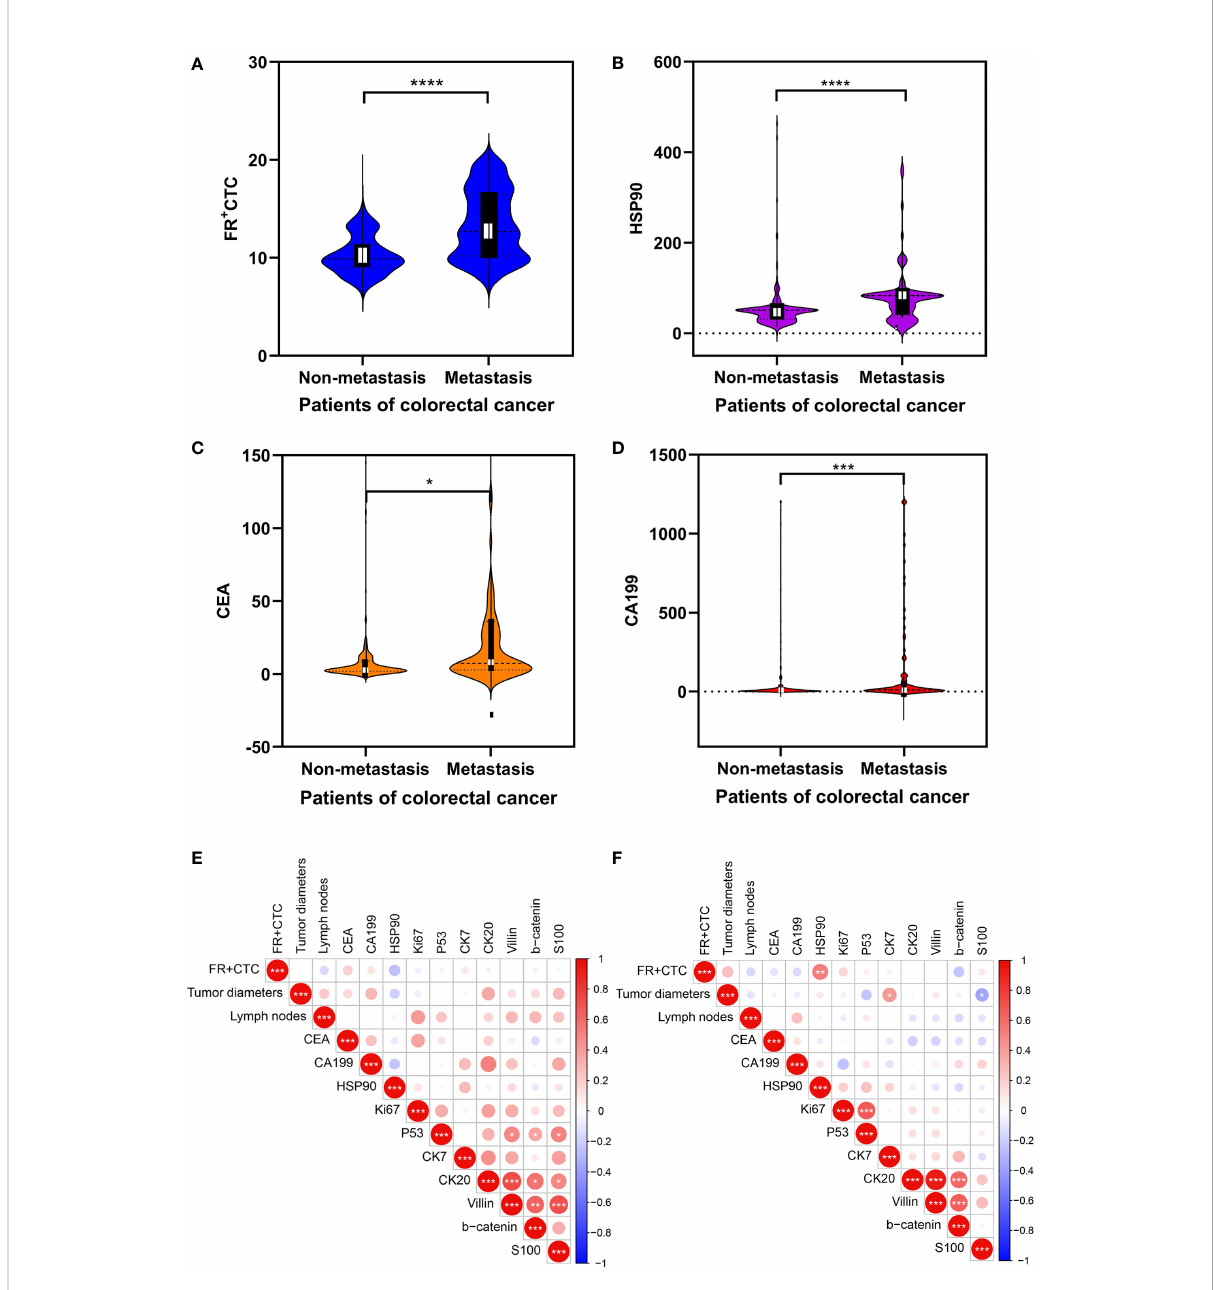
FIGURE 2 Analysis of clinical data of cohorts: (A – D) Comparison of the serology of folate receptor plus circulating tumor cells (FR+CTC), heat shock protein 90 (HSP90), CEA, and CA199 levels between colorectal cancer patients with and without liver metastasis. The data are presented as mean ± standard error of the mean (SEM). Heatmap expression matrix of serological marker correlations in non-metastatic (E) and metastatic colorectal cancers (F) . “ * ” Represents the p-value of the two groups after statistical test, * represents p<0.05, ** represents p<0.01, *** represents p<0.001, and **** represents